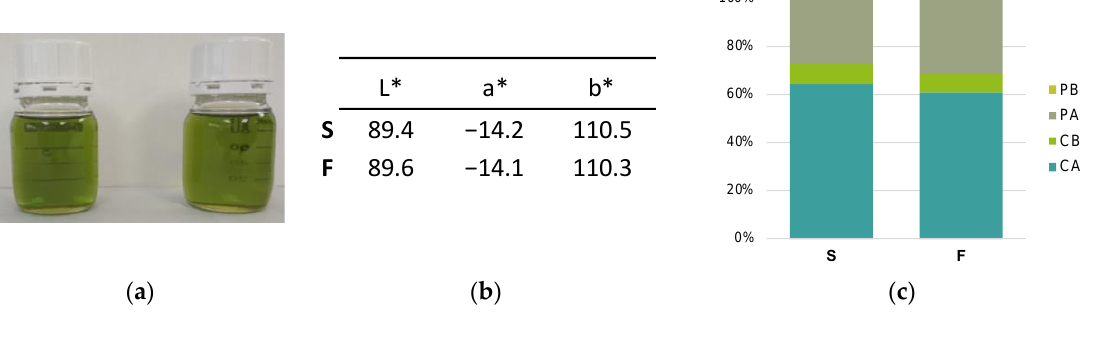
Figure 3. Results of the 24 h test (study III): ( a ) Image of the S (left) and F (right) oils after 24 h at − 20 °C; ( b ) Color measurements; ( c ) Chlorophyll and pheophytin profile of S and F oils, expressed as %. Abbreviations: S, oil frozen at − 20 °C; F, oil frozen with liquid nitrogen; CA, chlorophyll a ; CB, chlorophyll b ; PA, pheophytin a ; PB, pheophytin b .